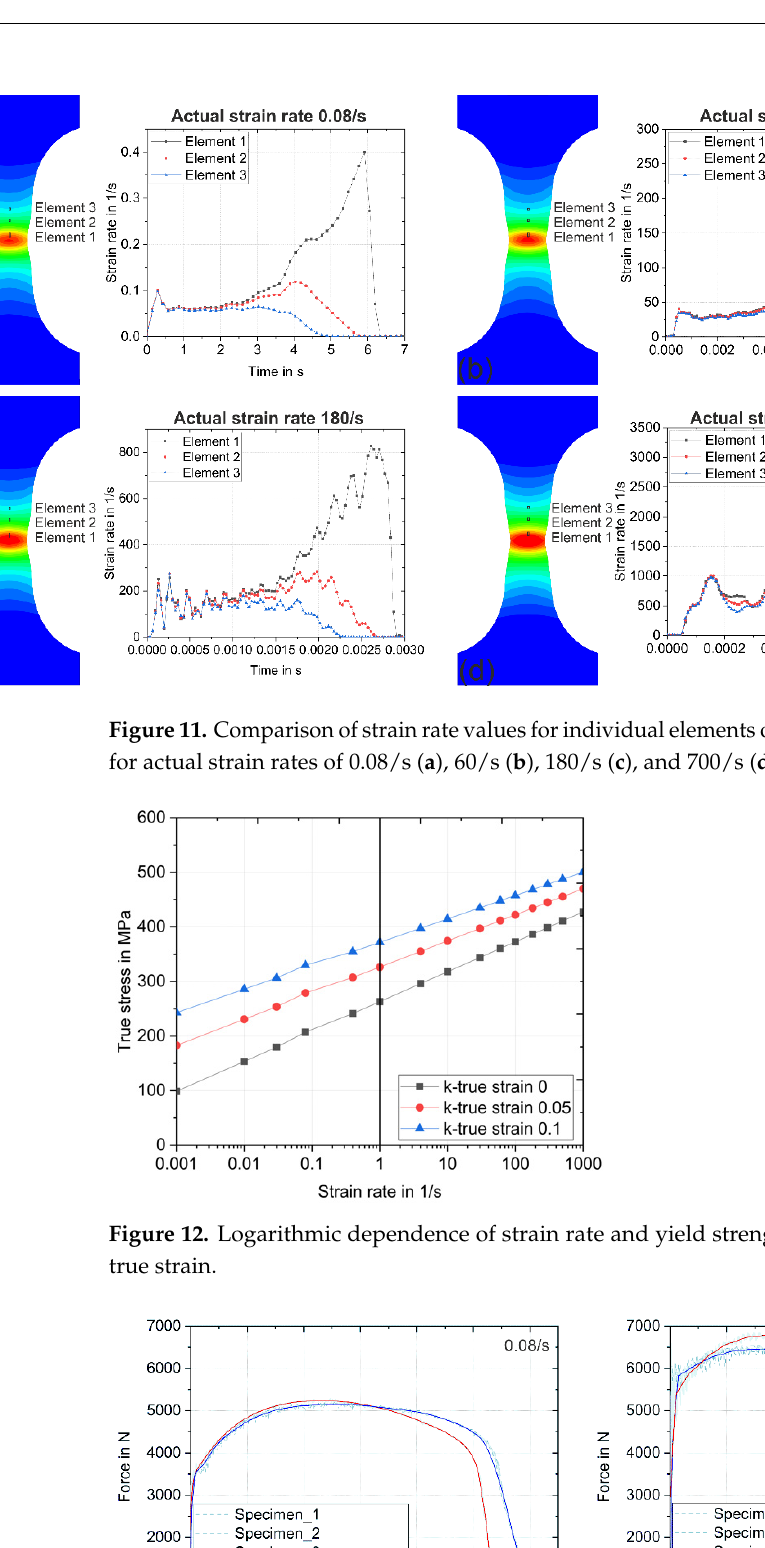
Figure 13. Comparison of experimental force-displacement curves with simulation results for actual strain rates of ( a ) 0.08/s and ( b ) 60/s.